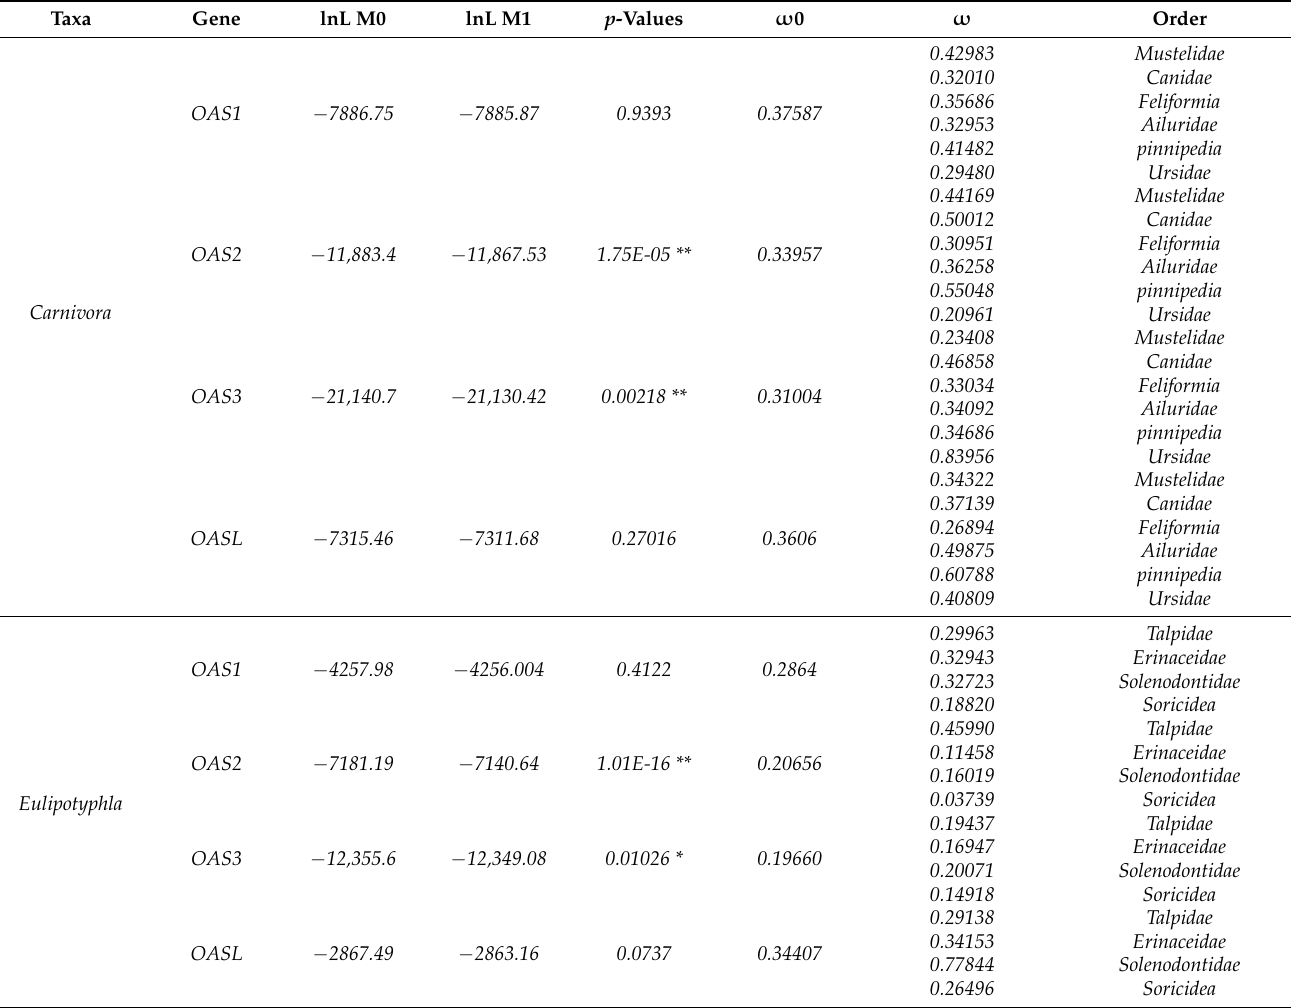
Table 3. Tests for positive selection in different clades of OAS genes with a branching